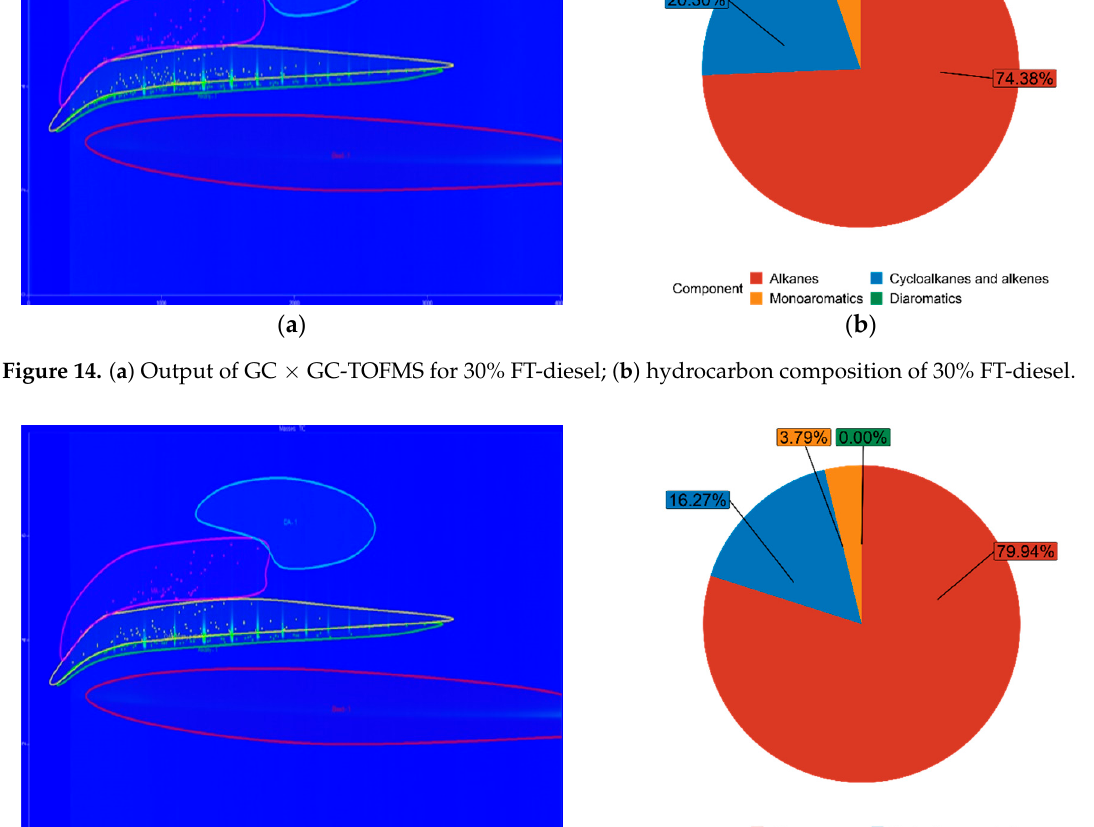
Figure 15. ( a ) Output of GC × GC-TOFMS for 50% FT − diesel; ( b ) hydrocarbon composition of 50% FT − diesel.